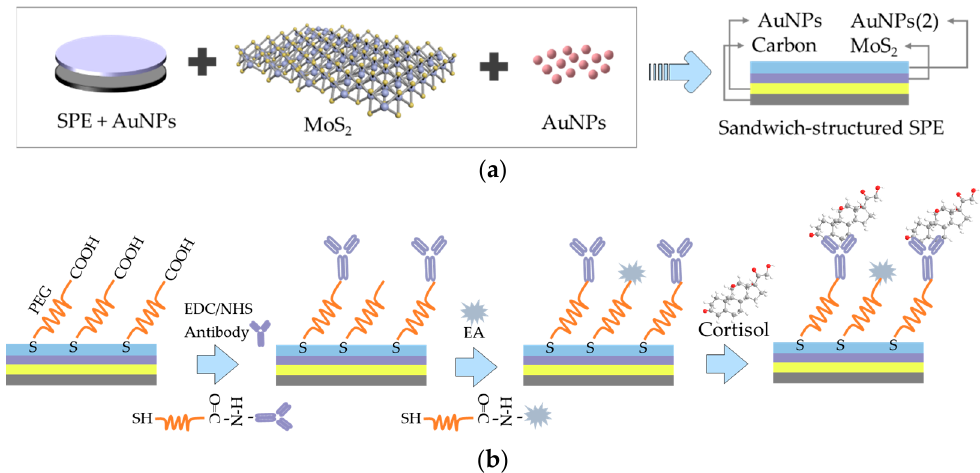
Figure 1. The construction and detection procedure of cortisol immunosensor. ( a ) Fabrication of layer-by-layer self-assembled gold nanoparticles/molybdenum disulfide/gold nanoparticles (AuNPs/MoS 2 /AuNPs) sandwich-structured screen-printed electrode (SPE), ( b ) covalent immobilization of cortisol antibody through self-assembled monolayer of polyethylene glycol